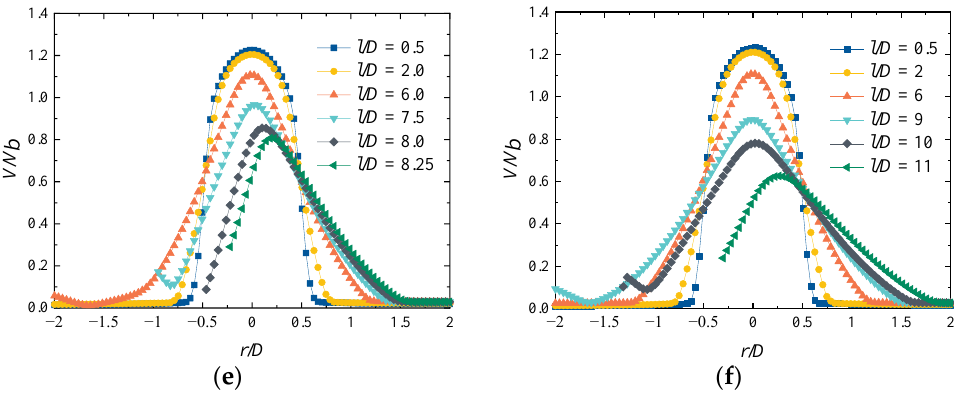
Figure 8. Radial profile development of the normalized mean axial velocity V/V b at various impinging heights: ( a ) H/D = 1; ( b ) H/D = 2; ( c ) H/D = 3; ( d ) H/D = 4; ( e ) H/D = 6; ( f ) H/D = 8. Figure 9 shows the axial profile development of velocity V/V b at different radial locations ( r/D = 0, ±0.25, and ±0.5) under various impinging heights ( Re = 35,100). Within the calculated height range, the flow distance of the jet between the nozzle and the impingement plane is l/D = h/(D × sin θ ) ≈ 1.4~11.3, and it is generally considered that the length of the jet potential core region is 4~6 D . Therefore, when H/D = 1~3, there is only the potential core region in the free-jet region, and the velocity V/V b remains fundamentally unchanged at r/D = 0 and ±0.25. When H/D ≥ 4, there is a transition region in the free-jet region, and the velocity V/V b at r/D = 0 and ±0.25 first remains unchanged and then decreases with the increase in l/D ; at r/D = ±0.5, the velocity V/V b increases gradually and then tends to be stable, and the momentum is the main factor driving the jet flow. In the impingement region, the velocity V/V b decreases gradually at r/D = 0, ±0.25 and −0 .5, and the velocity V/V b decreases slightly at r/D = 0.25 due to the jet deflecting in the downstream direction in the impingement region, and the increase in |Vx| is lower than the decrease in |Vz| in the impingement region; at r/D = 0.5, the velocity V/V b gradually increases, and the increment decreases with the increase in impinging height. When H/D = 1, the velocity V/V b increases by about 0.55, while when H/D = 8, the velocity is almost unchanged.